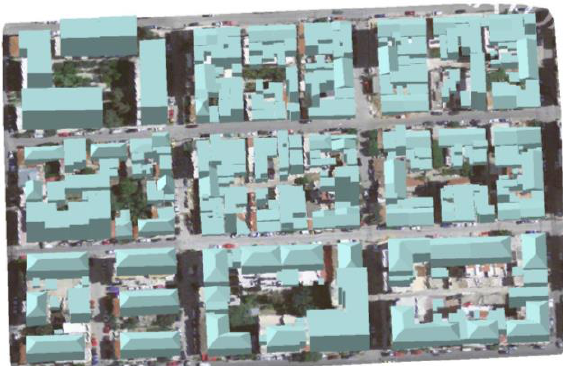
Figure 2. 3D models of external volumes of buildings of the study area in the reference epoch